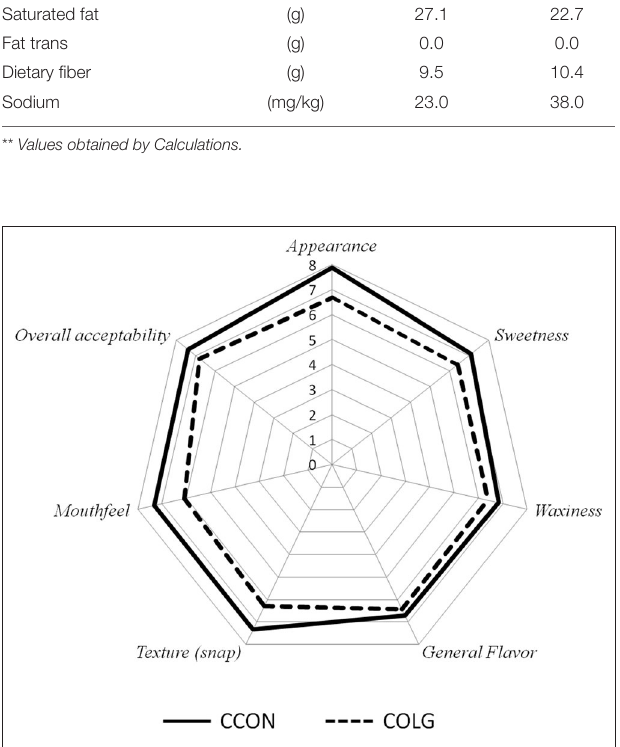
FIGURE 9 | Sensory evaluation of the attributes of — control chocolate (CC) and reduced fat chocolate − − −